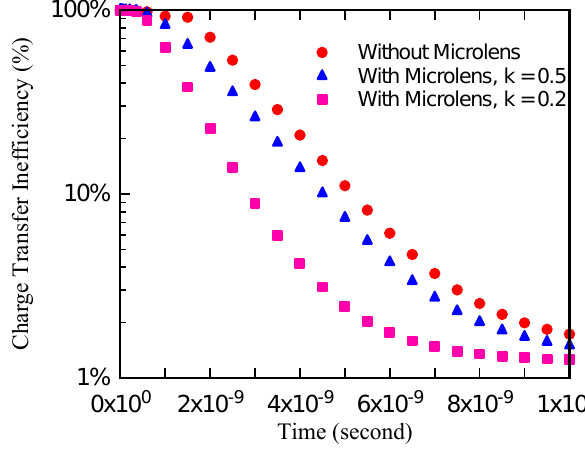
Figure 8. Electron transit time with on-chip microlens under 10,000e- illuminating